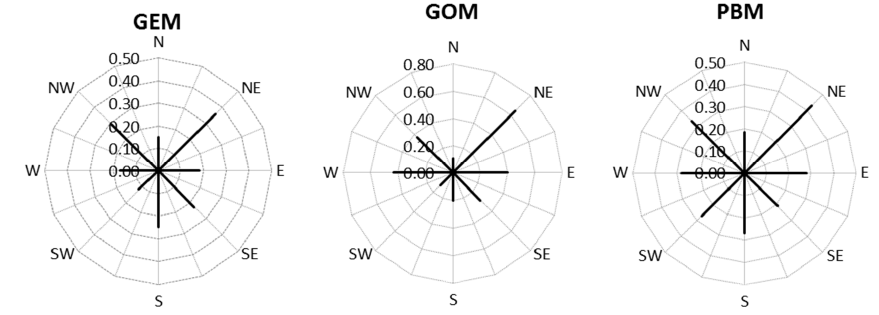
Fig. 3. Probability of winds coinciding with elevated GEM, GOM, and PBM concentrations ( ≥ 75th percentile) from each wind direction sector (also known as Conditional Probability